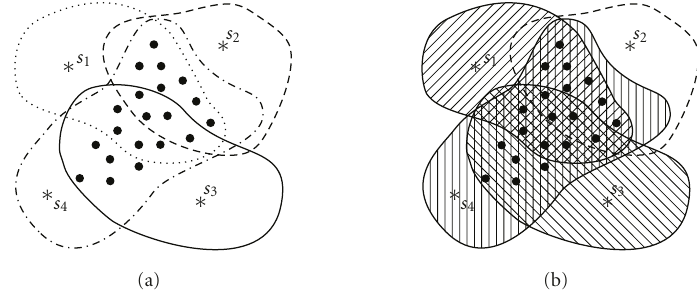
Figure 2: Illustrating k -SC problem. Suppose we are given 4 sensors of centers s 1 , ... , s 4 and 20 points as in (a). The problem is to select the minimum number of sensors to k -cover all points. A possible solution for k = 2 is shown in (b), where 3 sensors su ffi ce to 2-cover all